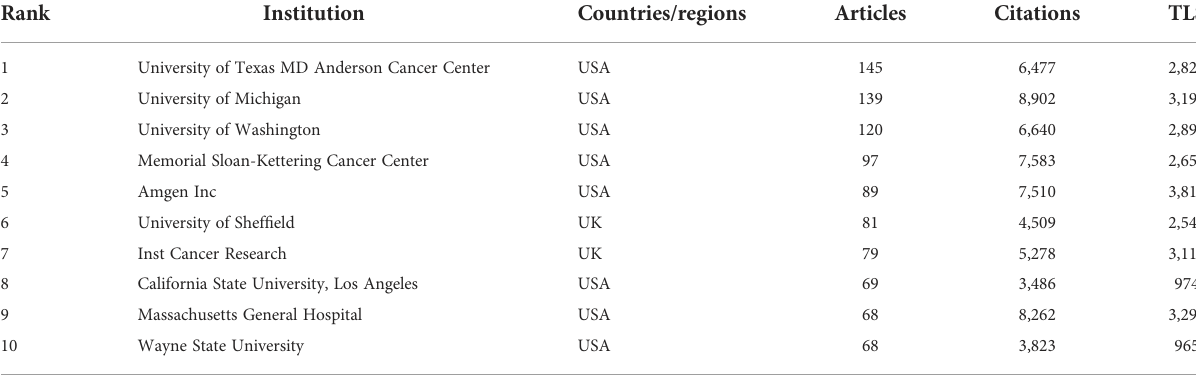
TABLE 2 Top 10 productive institutions in publications related to the research on bone metastases in prostate cancer. Rank Institution Countries/regions